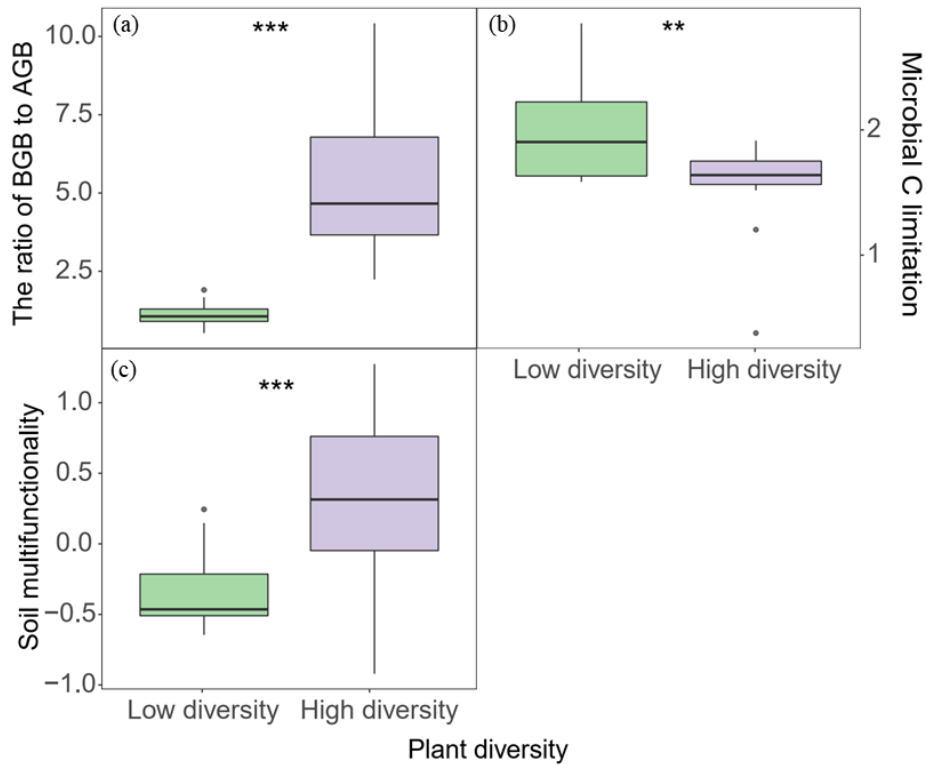
Figure 2. The ratio of BGB to AGB ( a ), microbial C limitation ( b ), and soil multifunctionality ( c ) in response to plant diversity. ** p < 0.01 and *** p < 0.001 ( t -test). AGB: above-ground biomass, BGB: below-ground biomass.